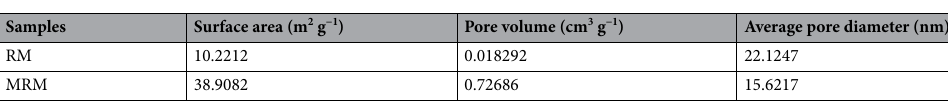
Table 1. BET surface area, pore volume and average pore diameter of the RM and MRM.